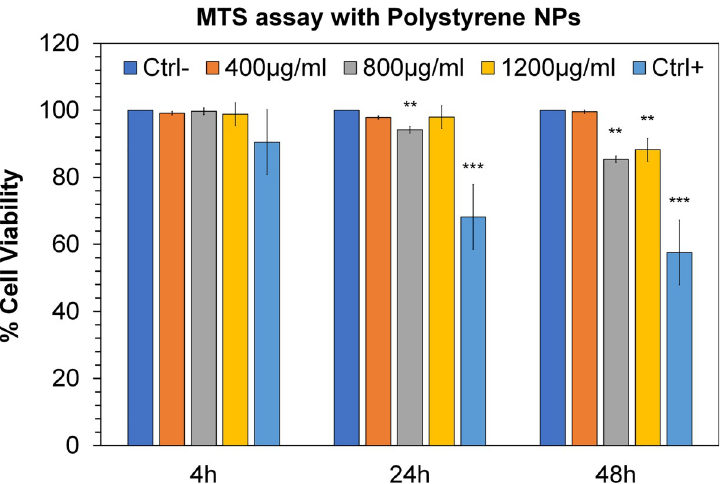
Fig 4. MTS test in HCT116 cells. The effects of polystyrene nanoparticles (PNPs) on HCT116 cell viability after exposures at 4, 24, and 48 h at 400, 800, and 1200 μ g/mL concentrations compared to the control cells. Triton-X-100 used as a positive control. Significance values � �� = p < 0.005; ��� = p < 0.0005; error bars represent the standard error of the mean.